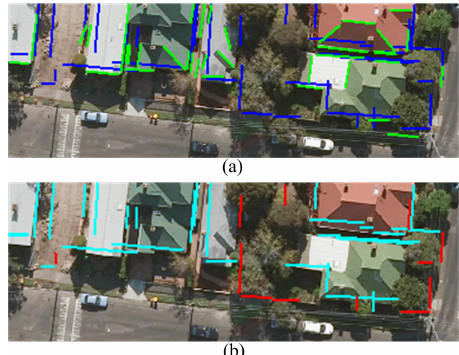
Figure 4: Use of neighbourhood information to remove tree- edges: (a) before voting: ‘blue’ represents lines from the pri- mary mask after the extending procedure and ‘green’ represents lines from the image and (b) after voting: ‘cyan’ represents ac- cepted lines after the voting procedure and ‘red’ represents re- jected lines.